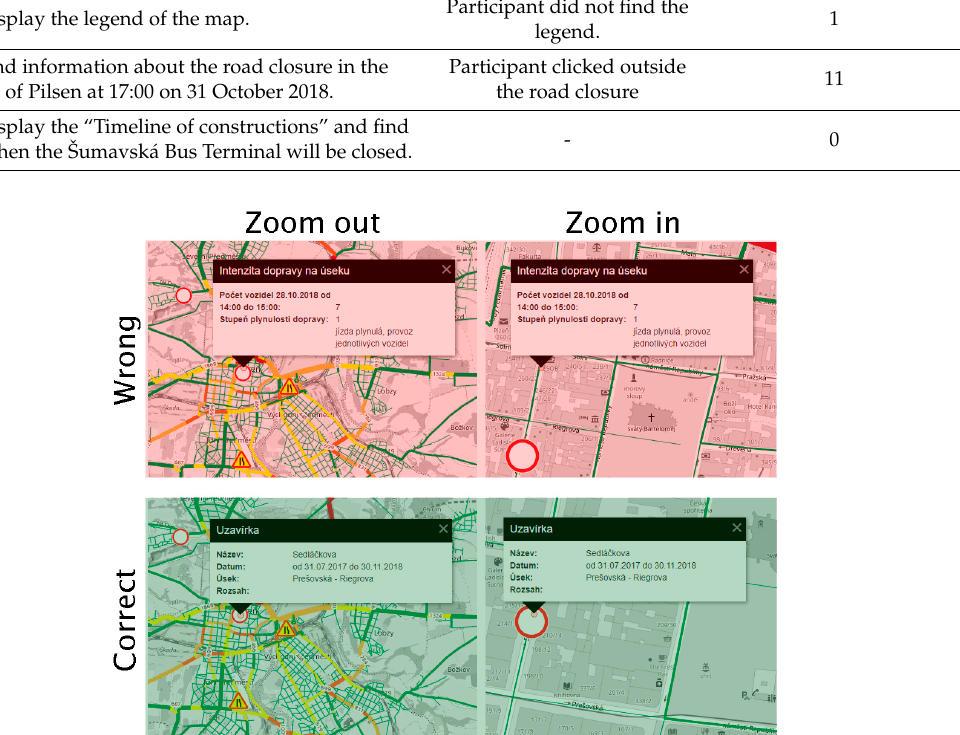
Figure 11. Problematic Task 3 in the Pilsen map.